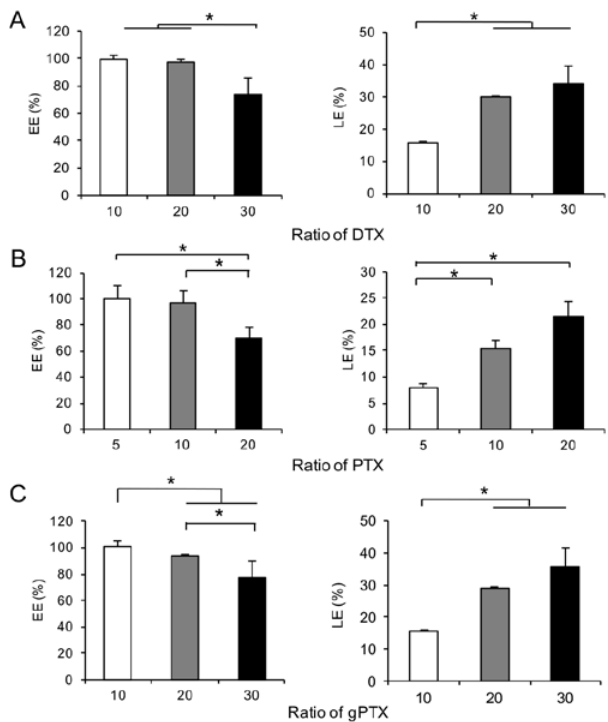
Figure 1. Encapsulation efficiency (EE) and loading efficiency (LE) of taxanes encapsulated into liposomes under different drug to lipid ratios. Liposomes composed of hydrogenated soybean phosphatidylcholine (HSPC), Chol, 1,2-distearoyl- sn -glycerol-3-phosphoethanolamine- N -[methoxy (polyethylene glycol)-2000] (mPEG-DSPE) and taxanes at the molar ratio of 60:40:5: x , x were prepared using CEP (20:15:65 volume%). ( A ) DTX-L. ( B ) PTX-L. ( C ) gPTX-L. Data are shown as mean ± S.D. where N = 4. * P < 0.05.